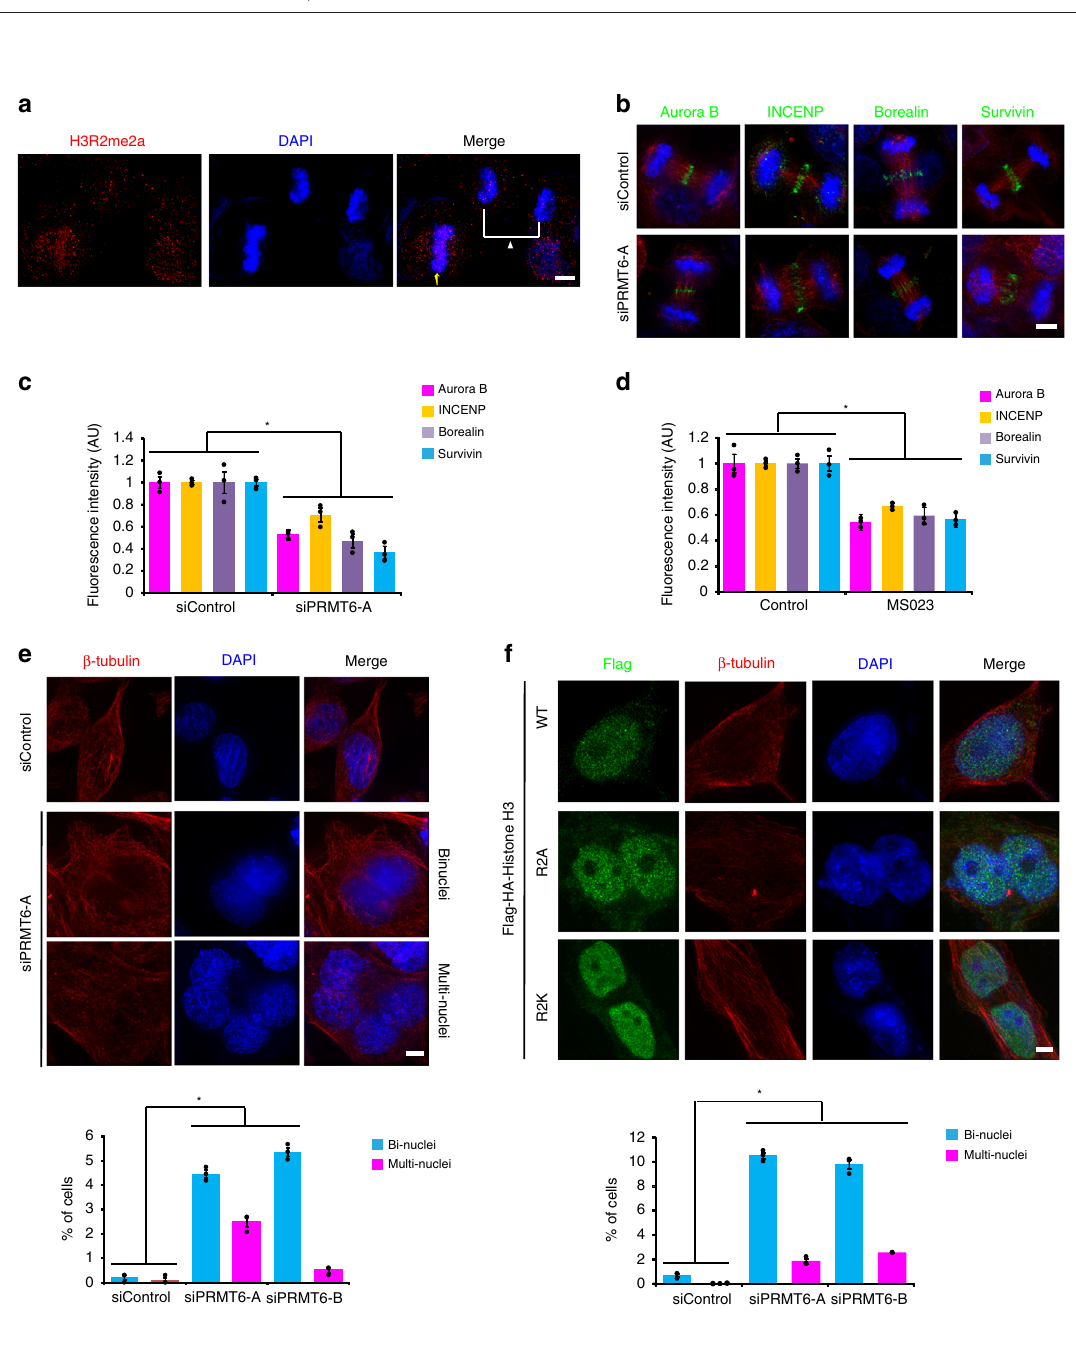
Fig. 5 Aurora B preferentially binds to H3R2me2a and recruits CPC components. a The amino acid sequences of modi fi ed histone H3 peptides. b In vitro Haspin kinase assay with the 21-aa peptide. c In vitro Aurora B kinase assay with the 21-aa peptide for phosphorylation. d In vitro PRMT6 methyltransferase assay. e – h The cells were treated with the siPRMT6, the PRMT6 inhibitor MS023, or the Haspin kinase inhibitor CHR-6494. The intensities of H3R2me2a ( f ) and H3T3ph ( h ) in the chromosome arm and centromere were analyzed by immuno fl uorescence microscopy of nocodazole-arrested HeLa chromosome spreads and were plotted ( n = 100 chromosomes from three independent experiments). i After transfection of the indicated plasmids, the HeLa cells were treated with a Haspin kinase inhibitor, CHR-6494, for 5h and the intensity of CPC components was analyzed for 100 centromeres from three independent experiments. j Recombinant CPC proteins were incubated with biotinylated histone peptides and pulled down with streptavidin-agarose beads, and the binding was visualized by immunoblotting. k Lysates of TN-arrested Aurora B-depleted cells were supplemented with recombinant Survivin and Borealin proteins with or without recombinant Aurora B protein. The lysates were incubated with antibodies against INCENP and the H3R2me2a peptide, and pulldown was conducted with agarose A beads. The binding was visualized by immunoblotting. The asterisk denotes the light chain of antibodies. l Lysates of TN-arrested mitotic HeLa cells were incubated with biotinylated histone peptides and pulled down with streptavidin-agarose beads, and the binding was visualized by immunoblotting. Relative band intensities of band were measured with image processing software (Image Studio ver5.0). Error bars, SEMs. Scale bars, 5 μ m. Source data are provided as a Source Data fi le. (Student ’ s t -test * p